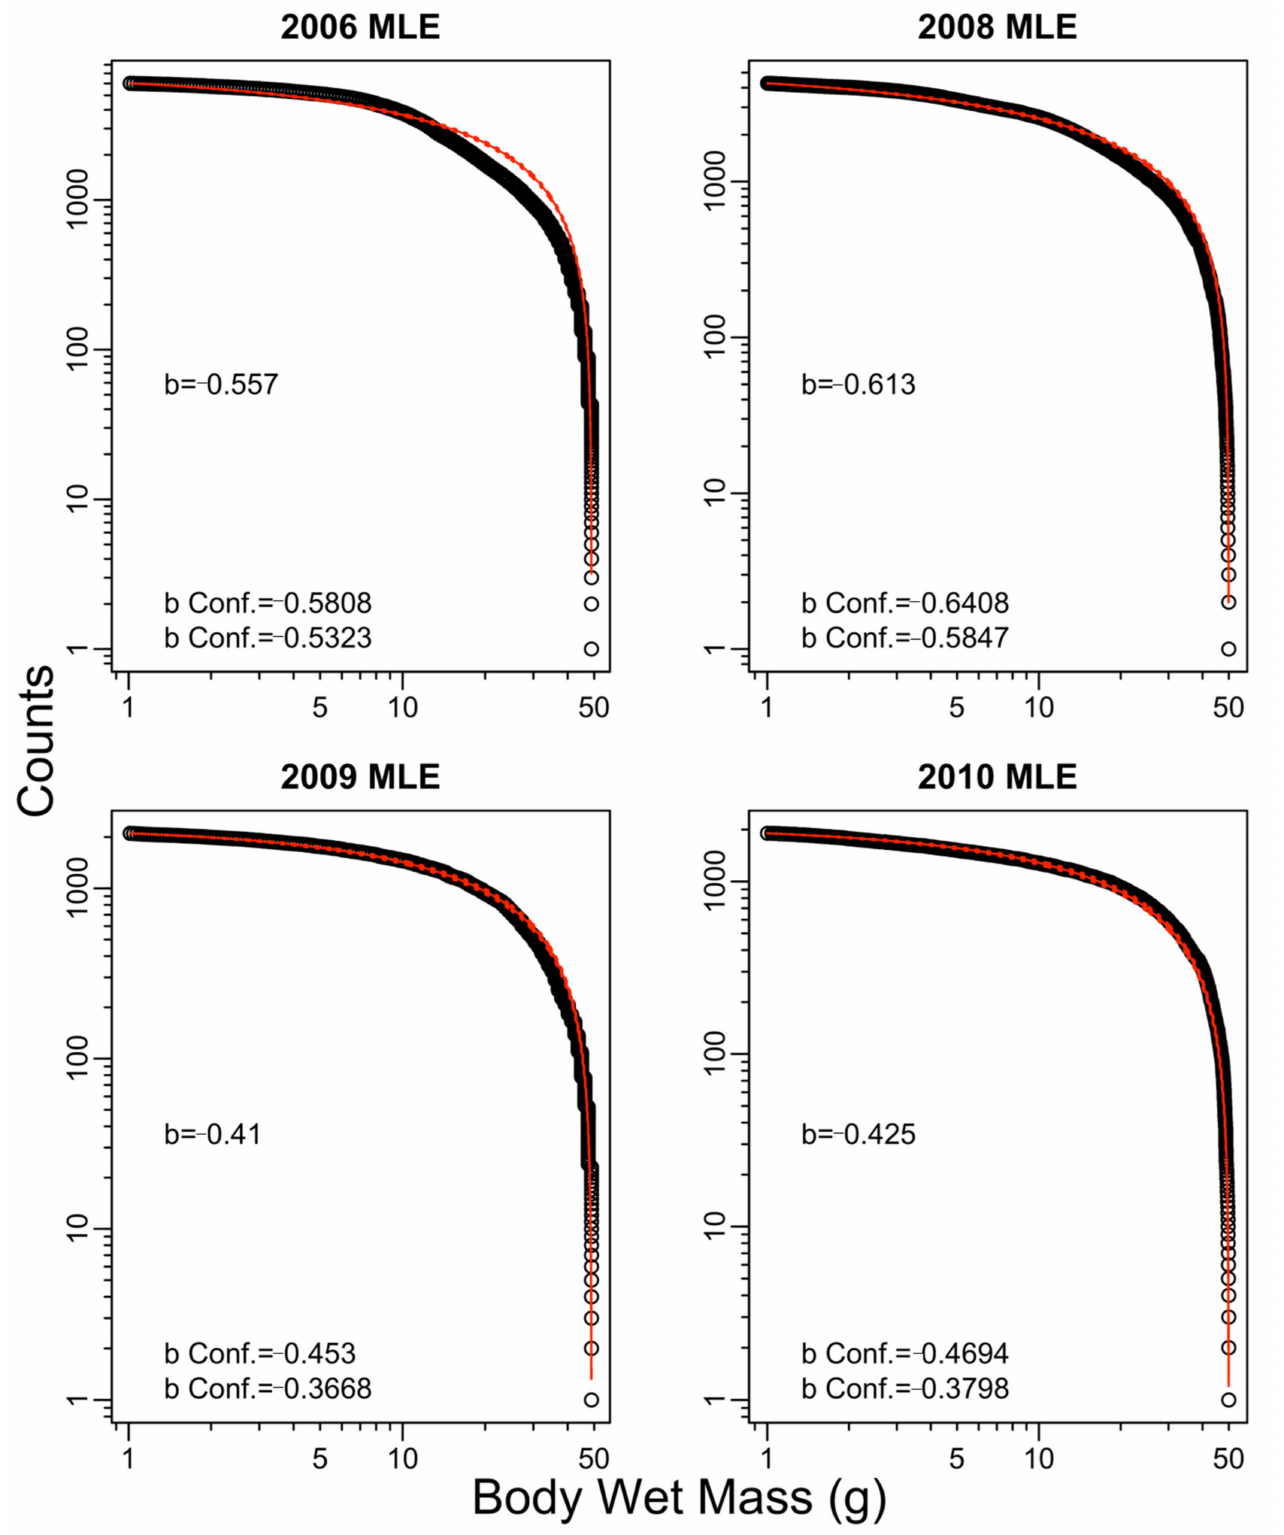
Figure A7. Fish SS with counts and body wet mass (g) fitted using the maximum likelihood estimate of exponent b with the 95% confidence interval of b based on track echo group (TEG) detection from hydroacoustic surveys for